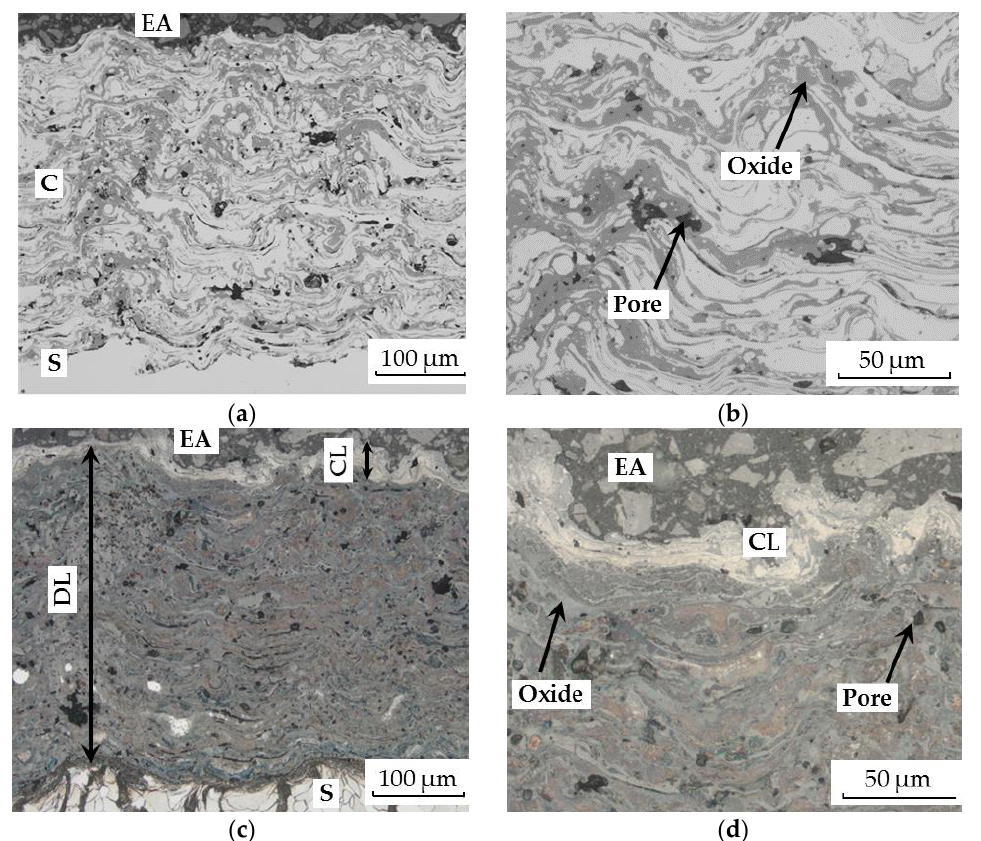
Figure 1. Light microscopic cross-section images of arc sprayed 17Cr-steel coatings: ( a , b ) as-sprayed; ( c , d ) gas nitrided after etching with Nital (EA = embedding agent, C = coating, S = substrate, CL = compound layer, DL = diffusion layer).